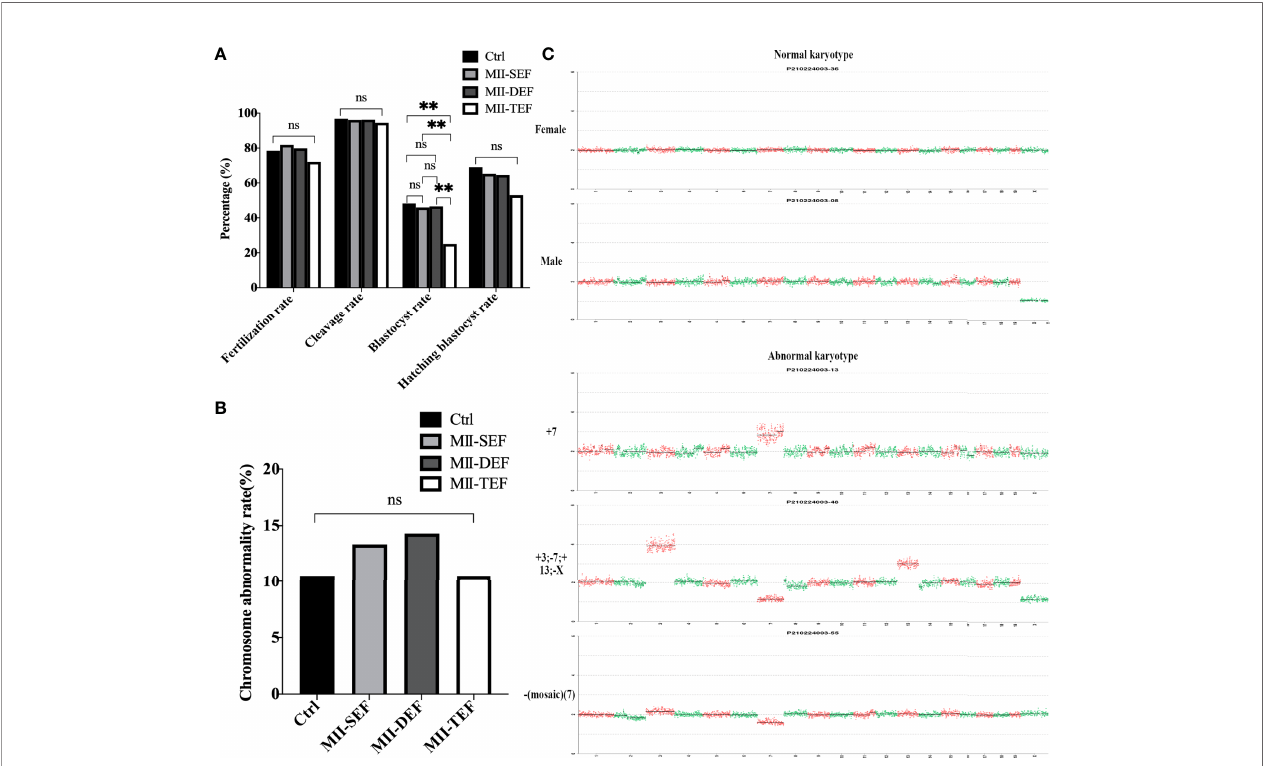
FIGURE 5 | Effect of electrofusion stimulation number on the developmental potential and chromosome karyotype of non-ST embryos. (A) The blastocyst rate in MII-TEF was signi fi cantly reduced. No signi fi cant difference existed in the fertilization rate, cleavage rate, and blastocyst hatching rate among the 4 groups. Data is expressed as a percentage (%). **P<0.01, ns P>0.05. (B) There was no statistical difference in the chromosome abnormality rate in blastocysts among the 4 groups. ns P>0.05. (C) The upper two images were normal karyotypes of female and male mouse blastocysts, respectively, the lower three images were